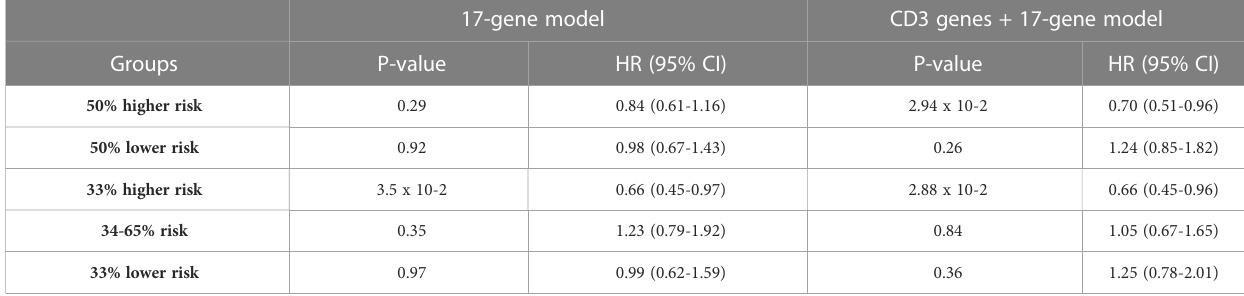
TABLE 1 Results of the cox models testing for differential PFS outcomes of the different groups of patients analyzed in the text.